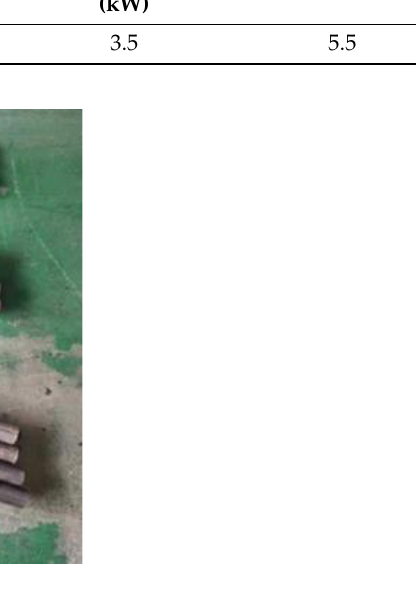
Figure 4. Coiled tubing with different radii of curvature.